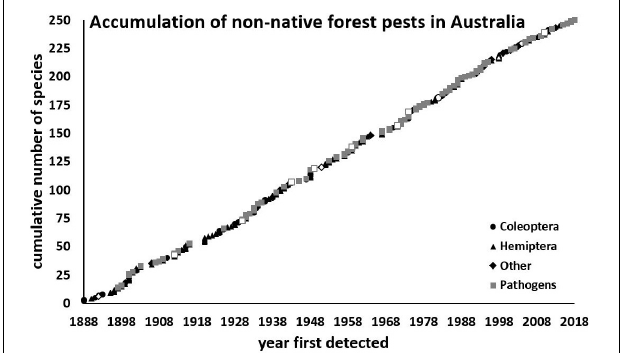
FIGURE 1 | Accumulation of forest arthropods (black: Hemiptera = triangles; Coleoptera = circles; other = diamond) and pathogens (gray squares) established in Australia between 1885 and 2018. Those with high impact are in outline format.